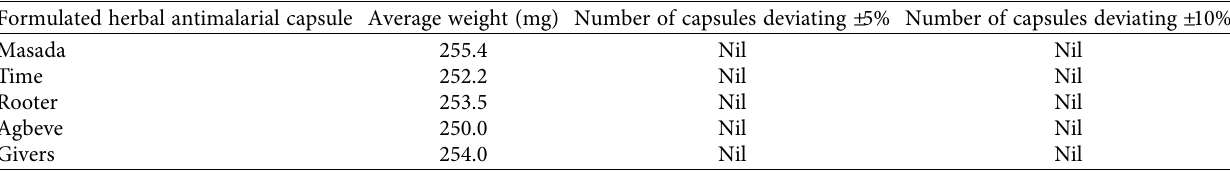
Figure 4: Statistical analysis on the absorbance of the extracts in the liquid herbal antimalarials, their dried powders, and formulated capsules ( n � 3) using one-way ANOVA followed by Tukey’s multiple comparisons test. P > 0 . 05; not significant (ns). Table 4: Uniformity of weight of formulated capsules.